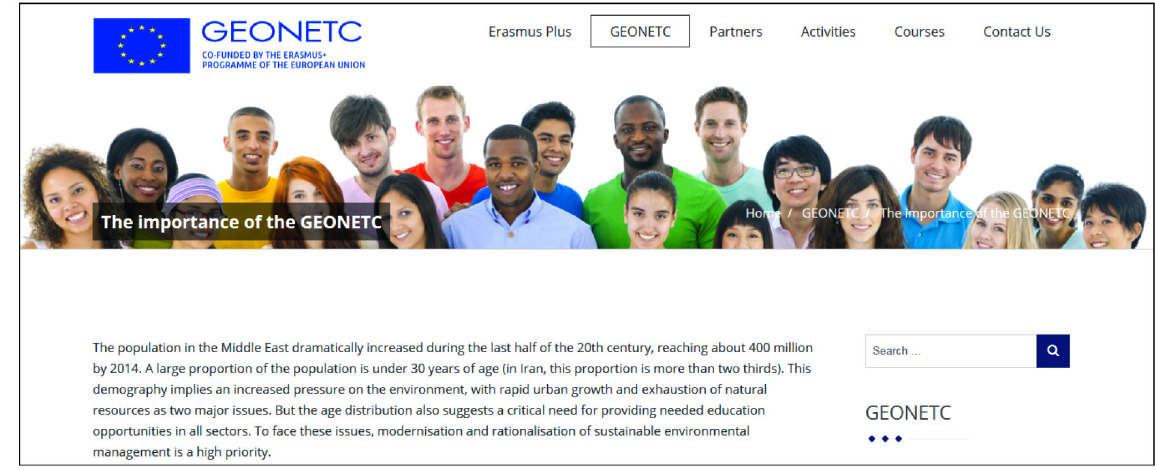
Figure 1. First page of GeoNetC web